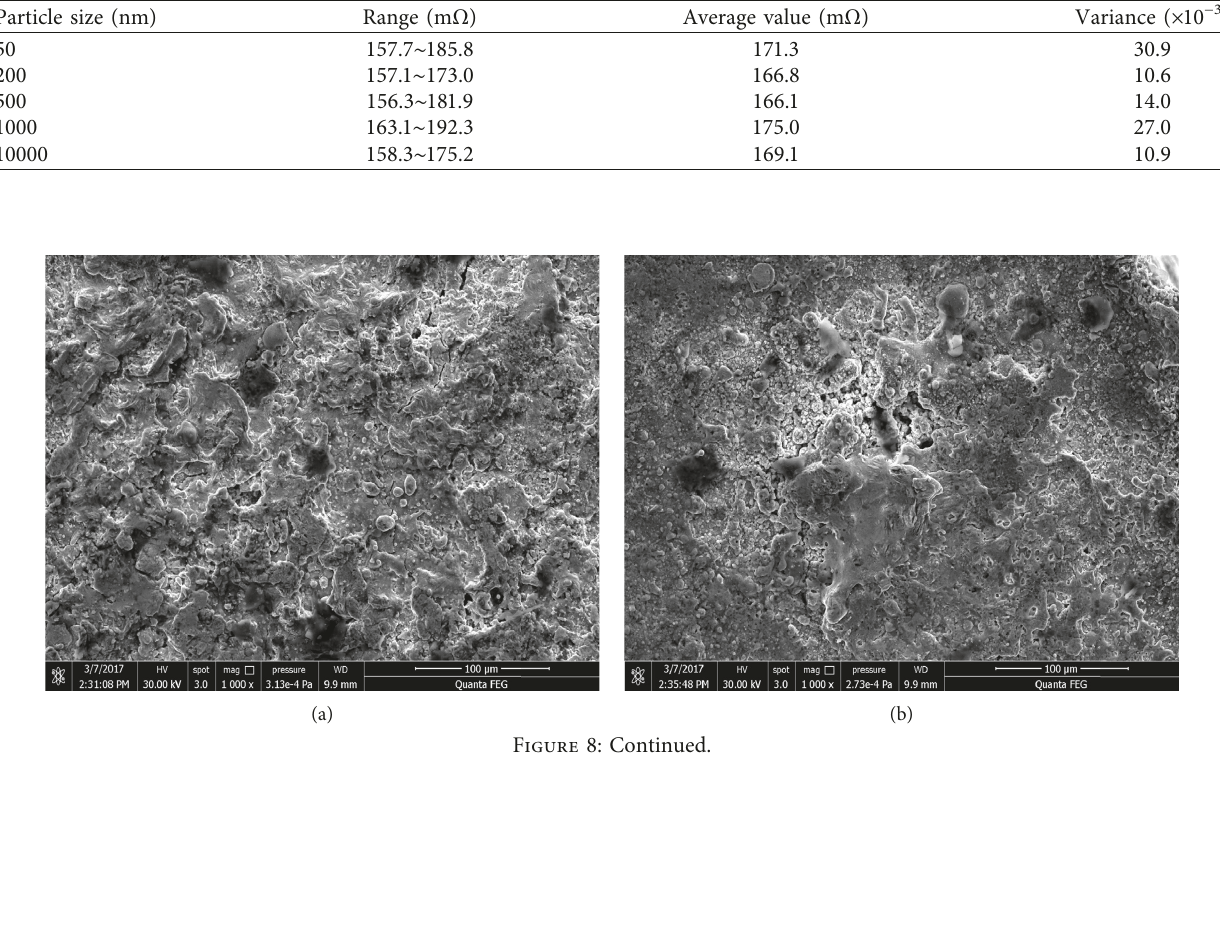
Table 7: The arc energy of AgSnO